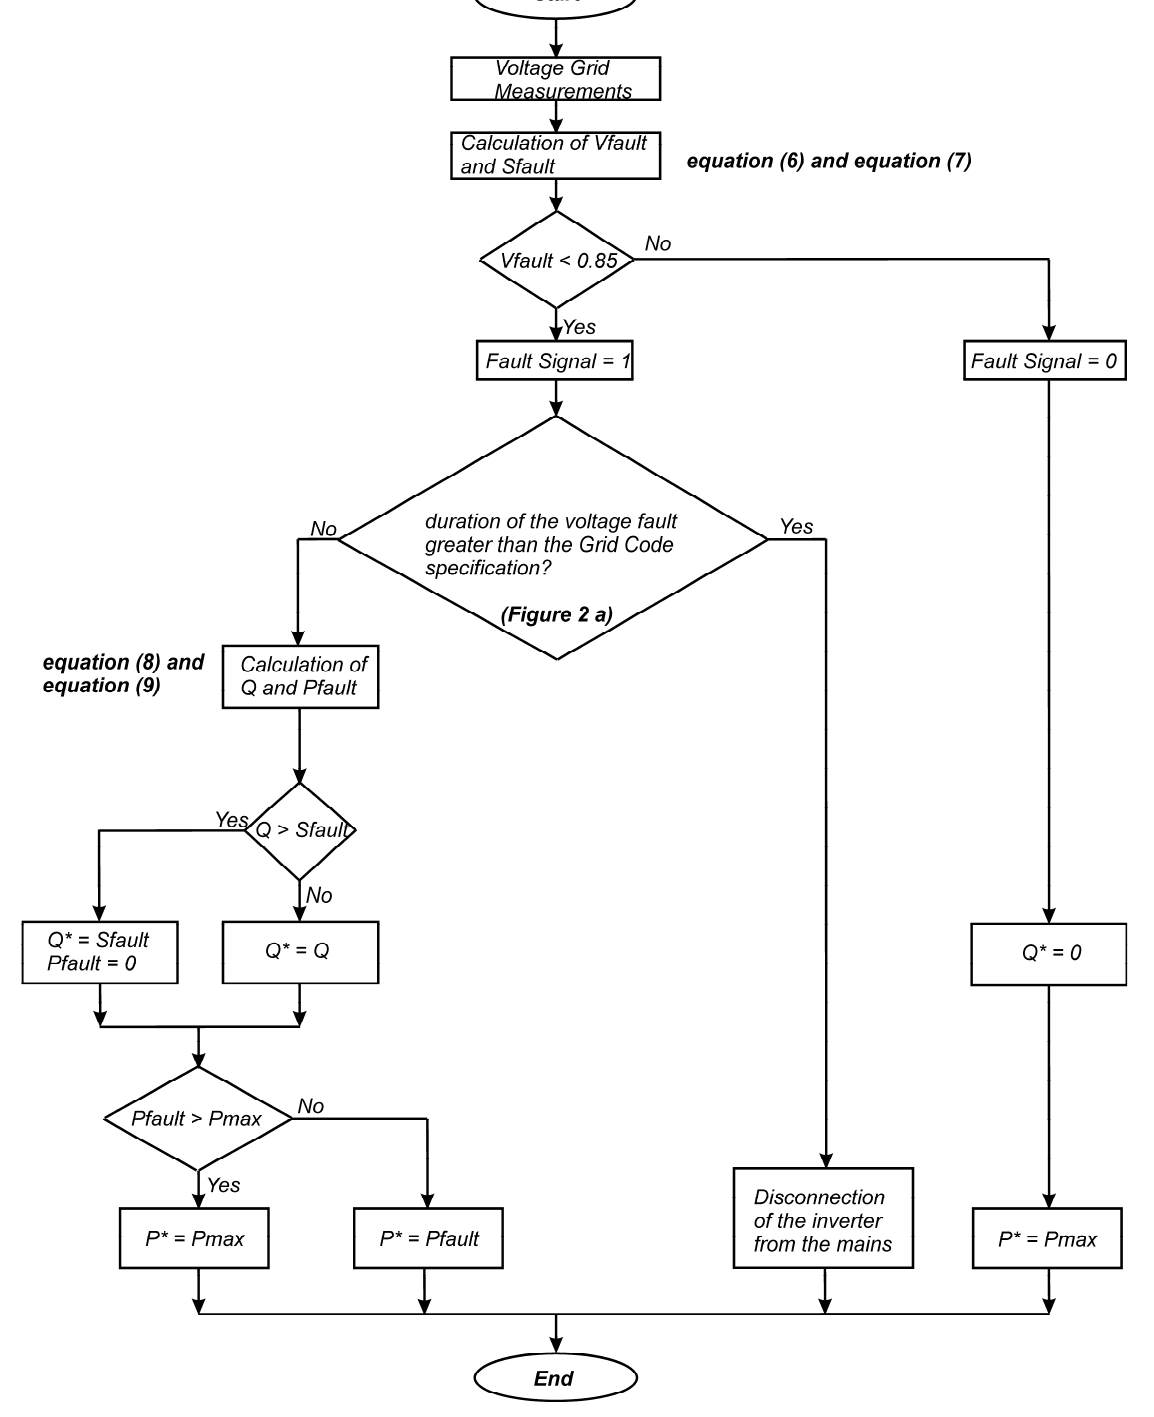
Figure 3. Flowchart of the proposed low-voltage ride-through control